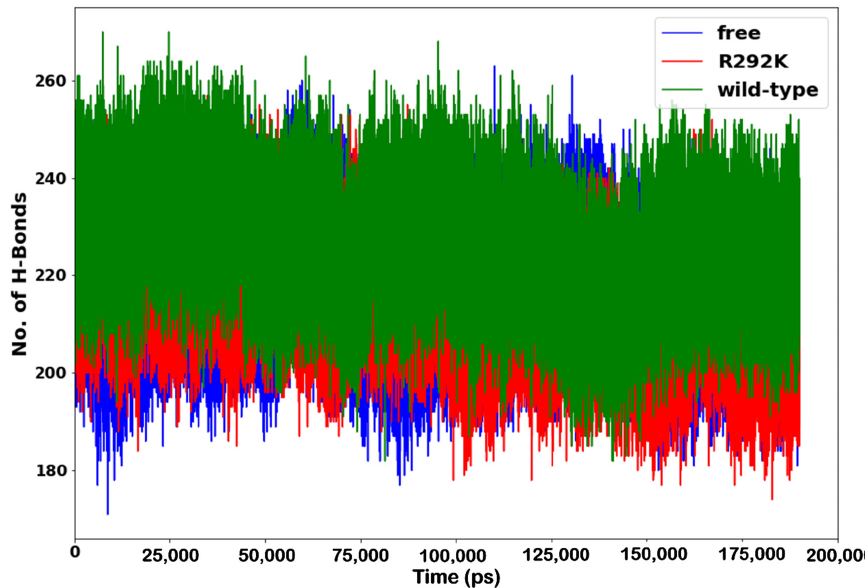
Figure 6. Amino acid residue interactions with peramivir in the active site of the wild-type ( A ) and R292K mutant ( B ) at 20 ns, 100 ns, and 200 ns simulation time.